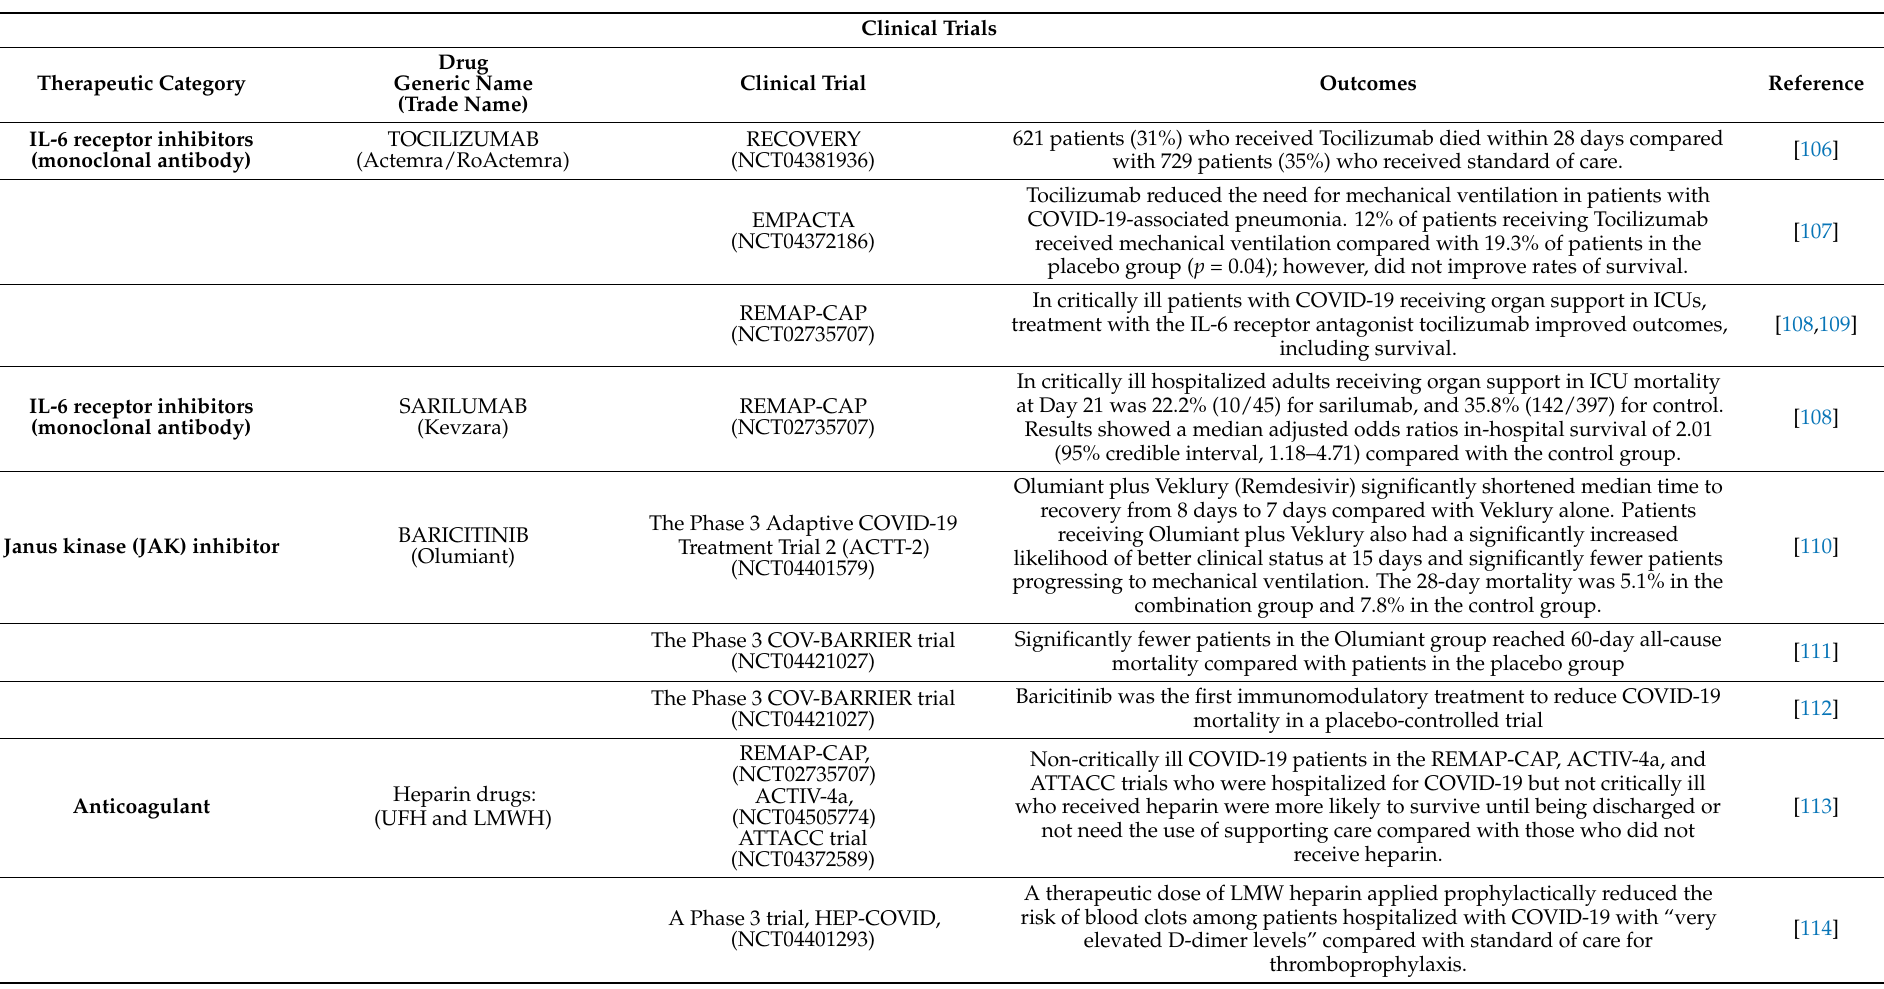
Table 1. Therapeutic intervention against